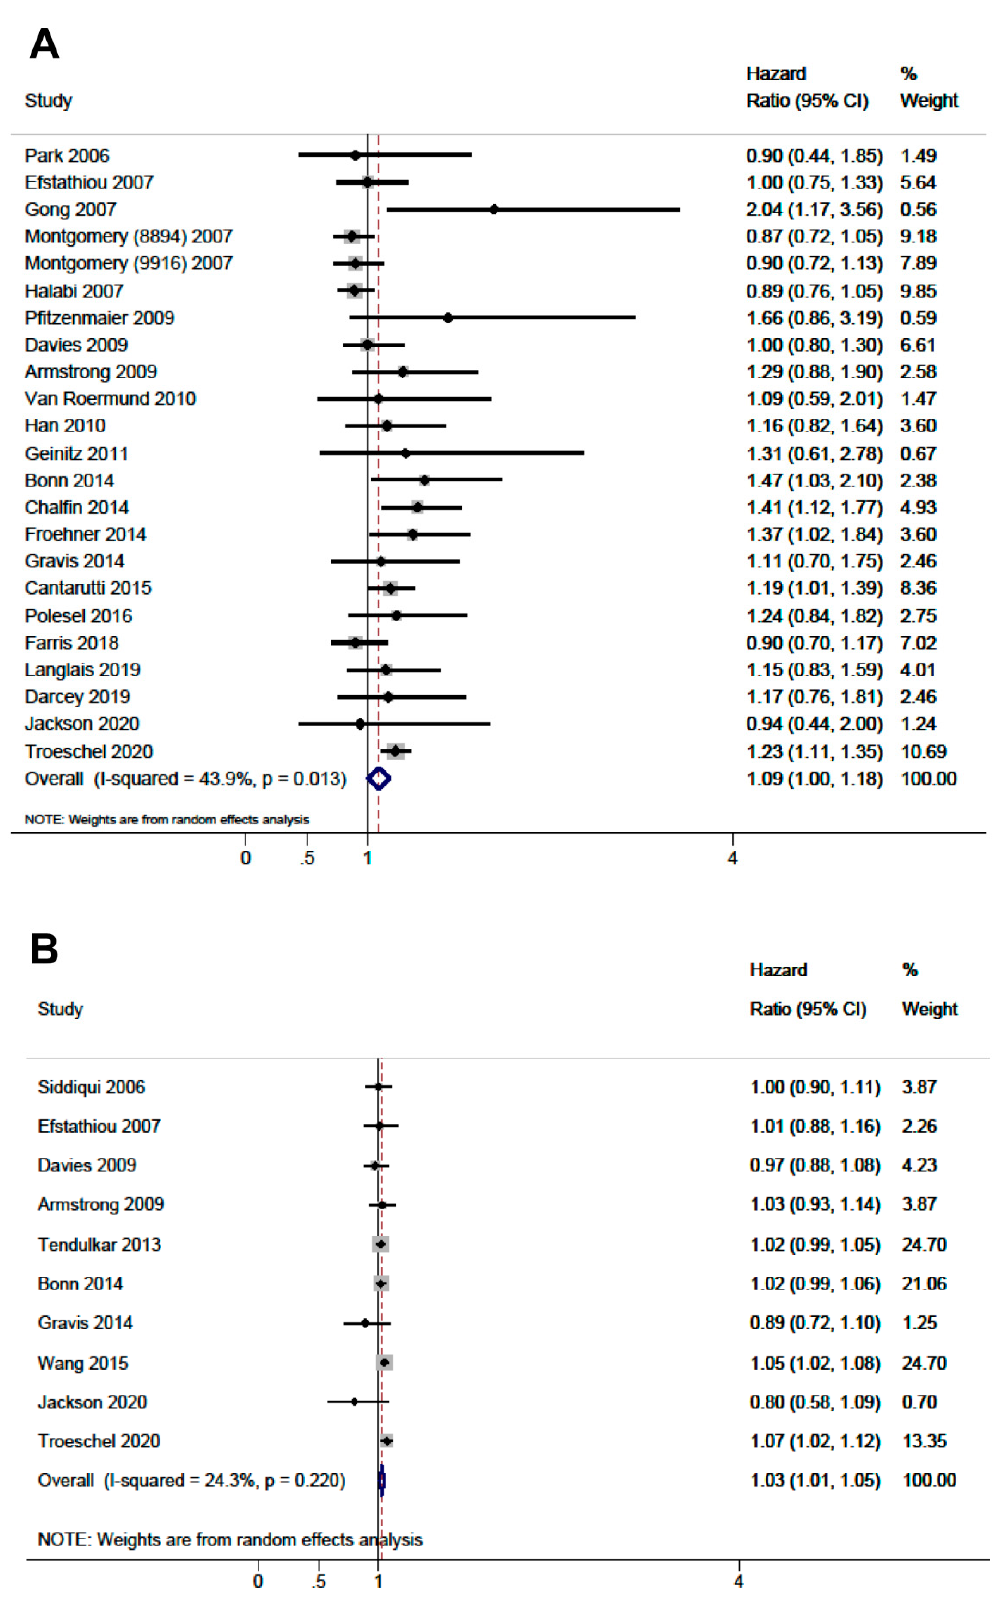
Figure 4. Forest plots of the association for all-cause mortality. ( A ) Obesity (body mass index ≥ 30 kg/m 2 ) compared to normal weight (body mass index < 25 kg/m 2 ). ( B ) Continuous body mass index per 5 kg/m 2 increment.